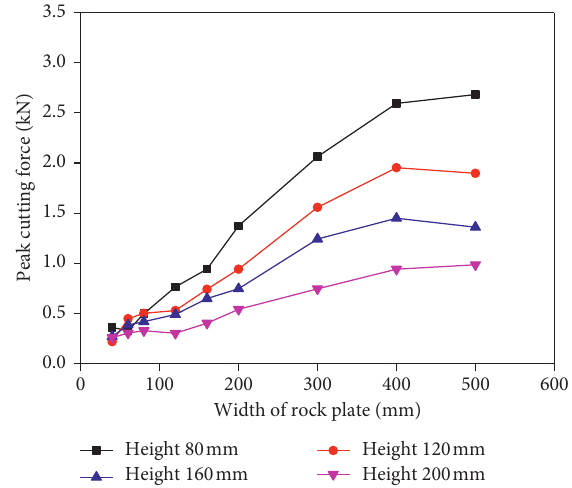
Figure 9: Variation in PCF with